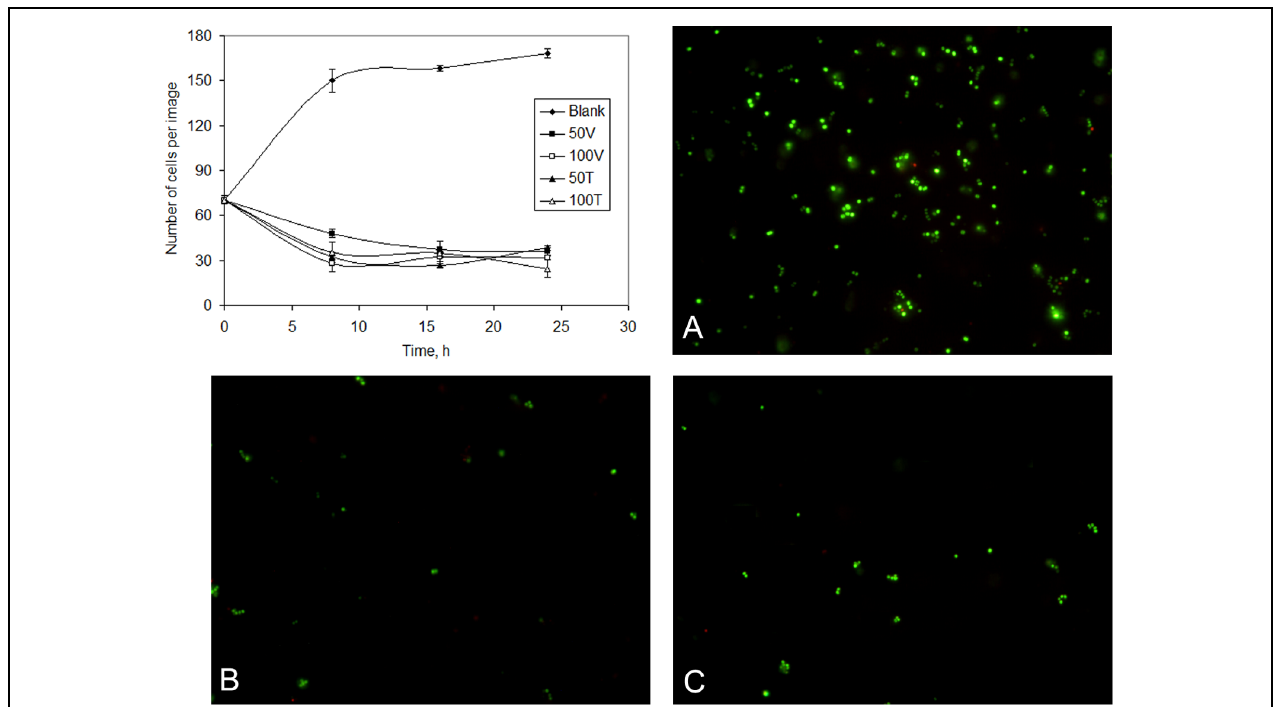
FIGURE 2 | Number of cells of S. aureus cells observed per image (chart) in unchallenged (blank) and following different periods of exposure to 50 and 100 mg/L teicoplanin (50T and 100T) and vancomycin (50V and 100V). Cultures observed by fluorescence microscopy during the exponential phase (A) , and after exposure to 100 mg/L teicoplanin (B) and vancomycin (C) for 24 h. Viable cells are stained green whilst non-viable cells are stained red by the LIVE/DEAD viability